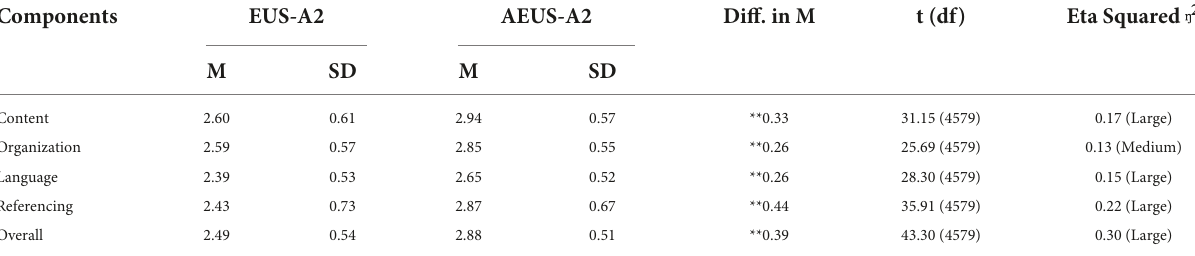
TABLE 4 Progression of students (differences in